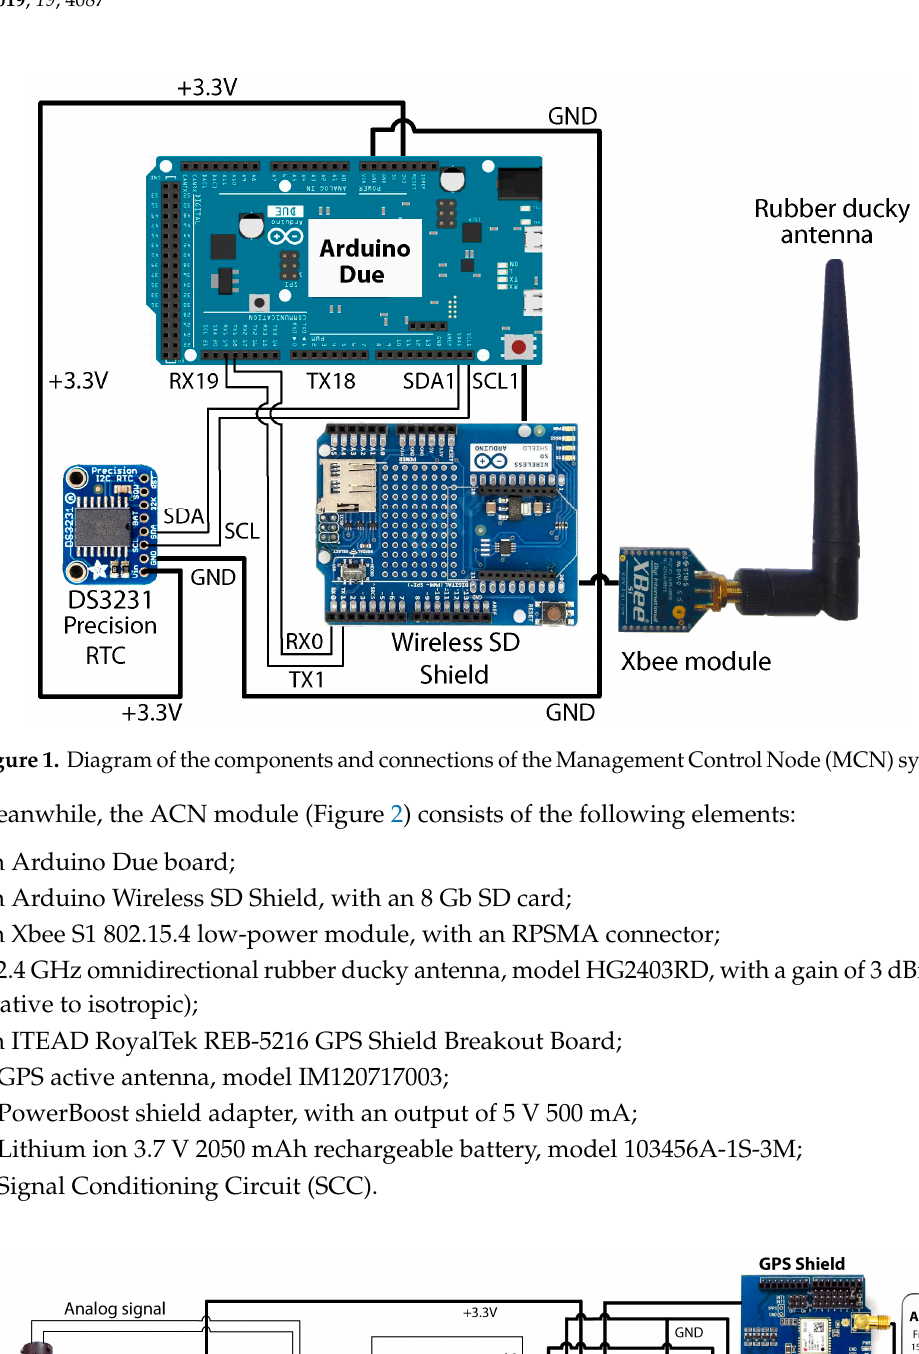
Figure 3. Schematic circuit of the Signal Conditioning Circuit (SCC) (made with Eagle free software). Figure 4. Example of an SCC with welded components.